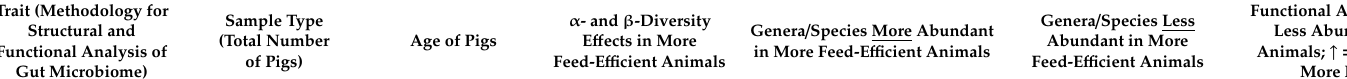
Trait (Methodology for Structural